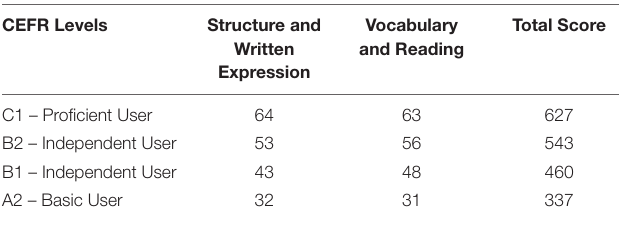
TABLE 1 | Levels of the Common European Framework of References for Languages (CEFR) and the respective score values in the TOEFL ITP R (cid:13) (Tannenbaum and Baron,